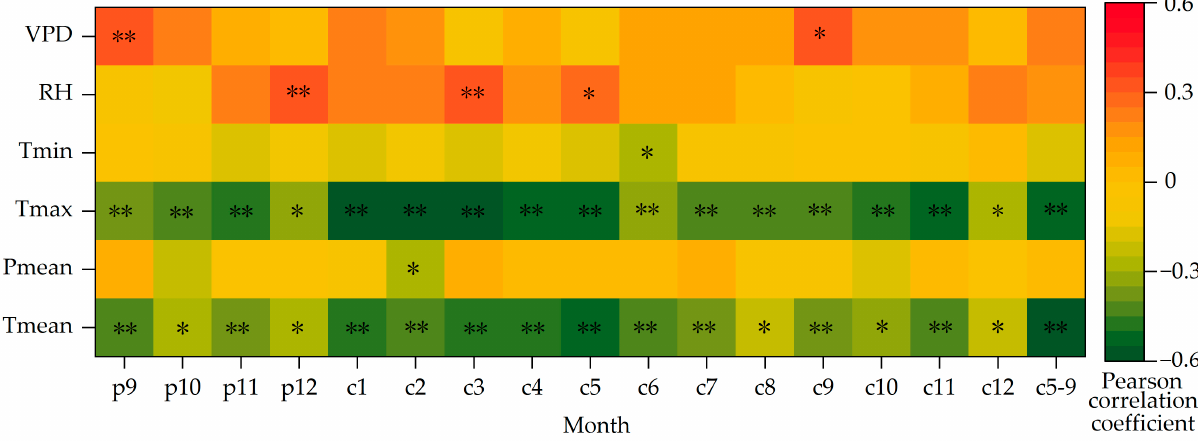
Figure 7. Correlations between δ 13 C of Picea meyeri and monthly meteorological factors on Luya mountain (c represents the current year and p represents the previous year; * and ** symbol represent signi fi cant correlation at the 0.05 and 0.01 level, respectively).